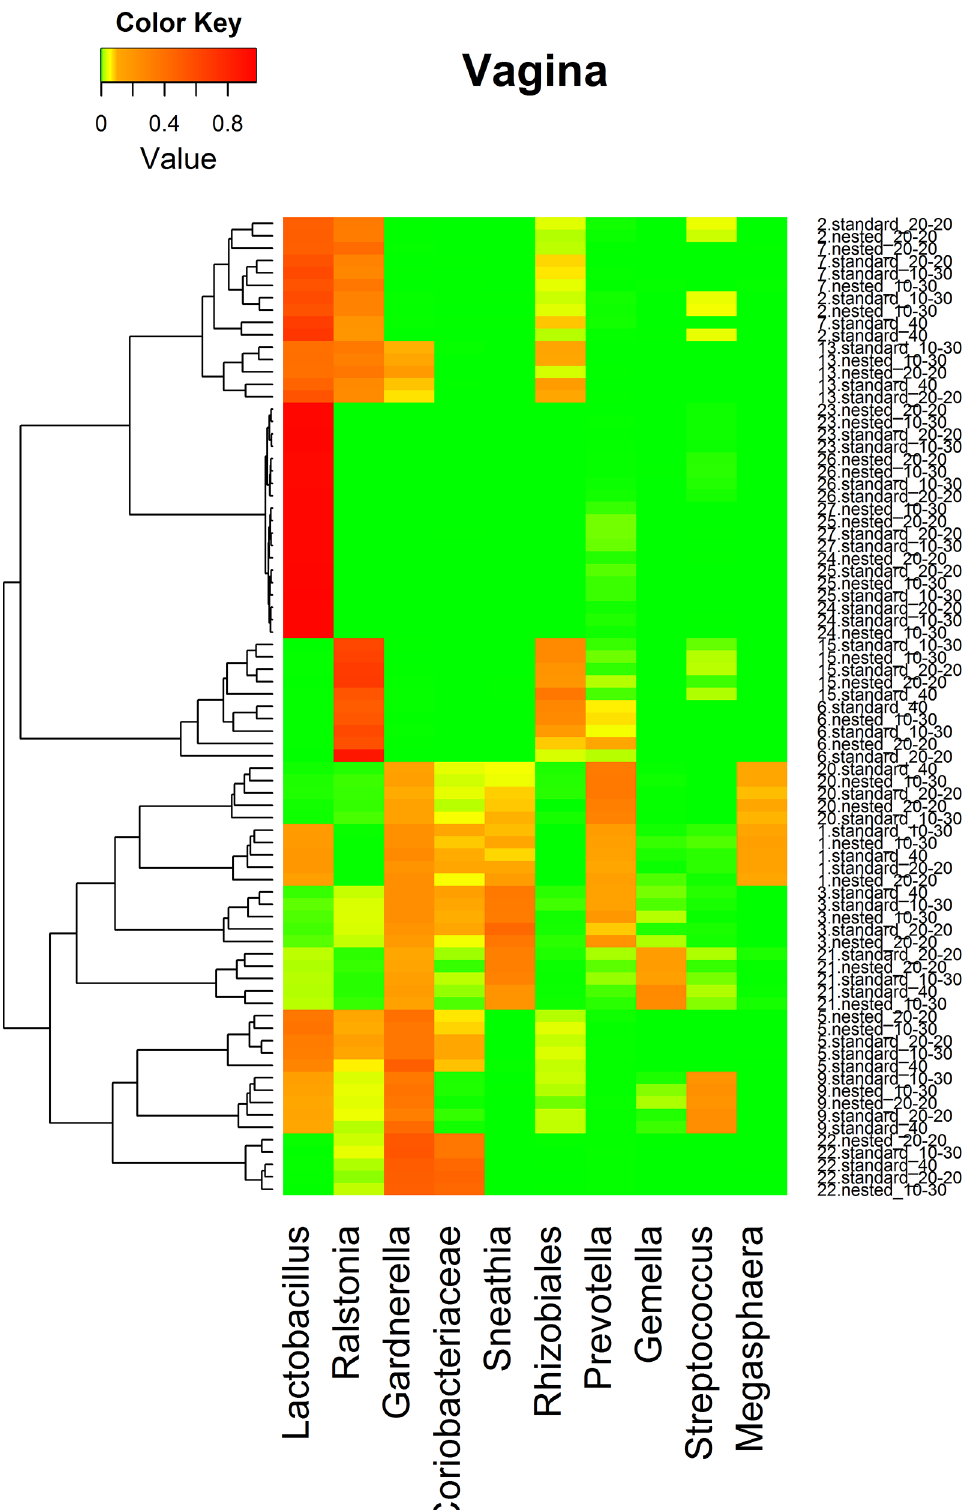
Fig 4. Clusters of vagina samples based on bacterial genus relative abundance. Heatmaps were based on the hierarchical clustering solution (Bray- Curtis) distance metric and average clustering method. Row represents different sample ID (The number before the period is the subject ID; The text after the